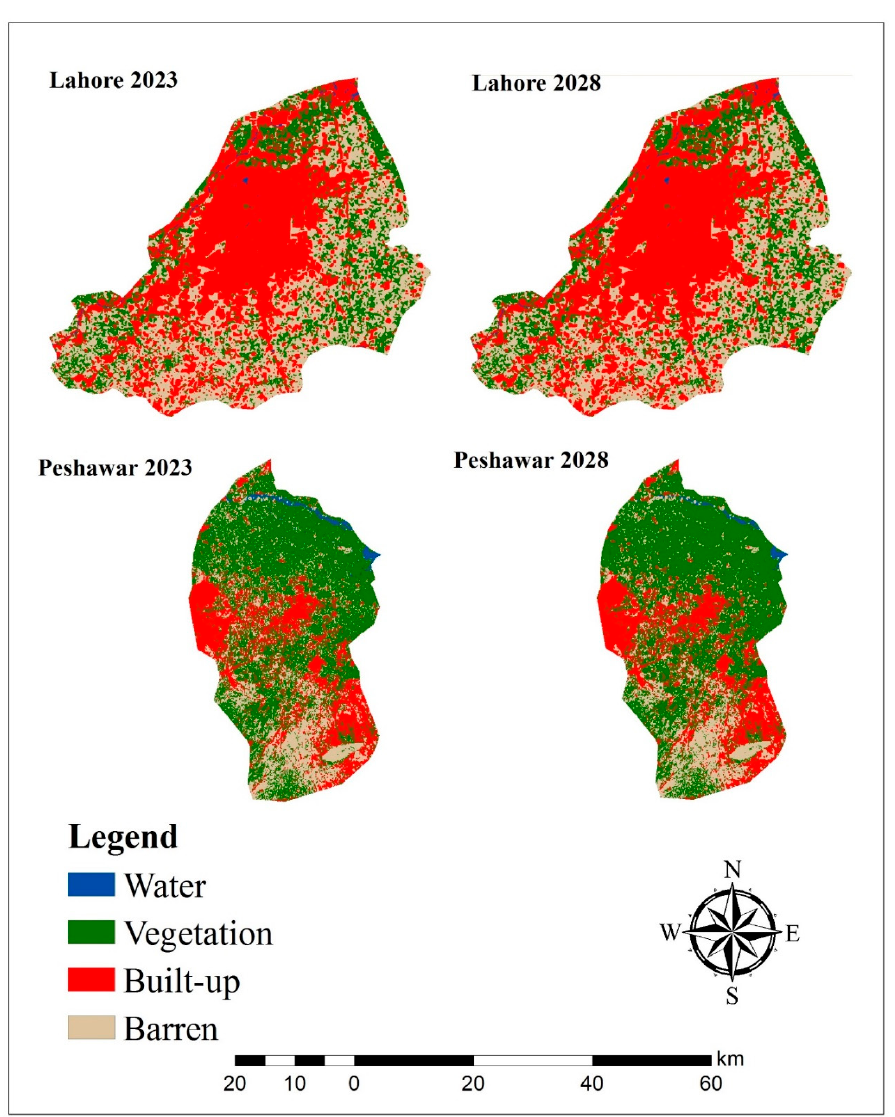
Figure 6. LULC predictions for 2023 and 2028 for Lahore city and Peshawar city.